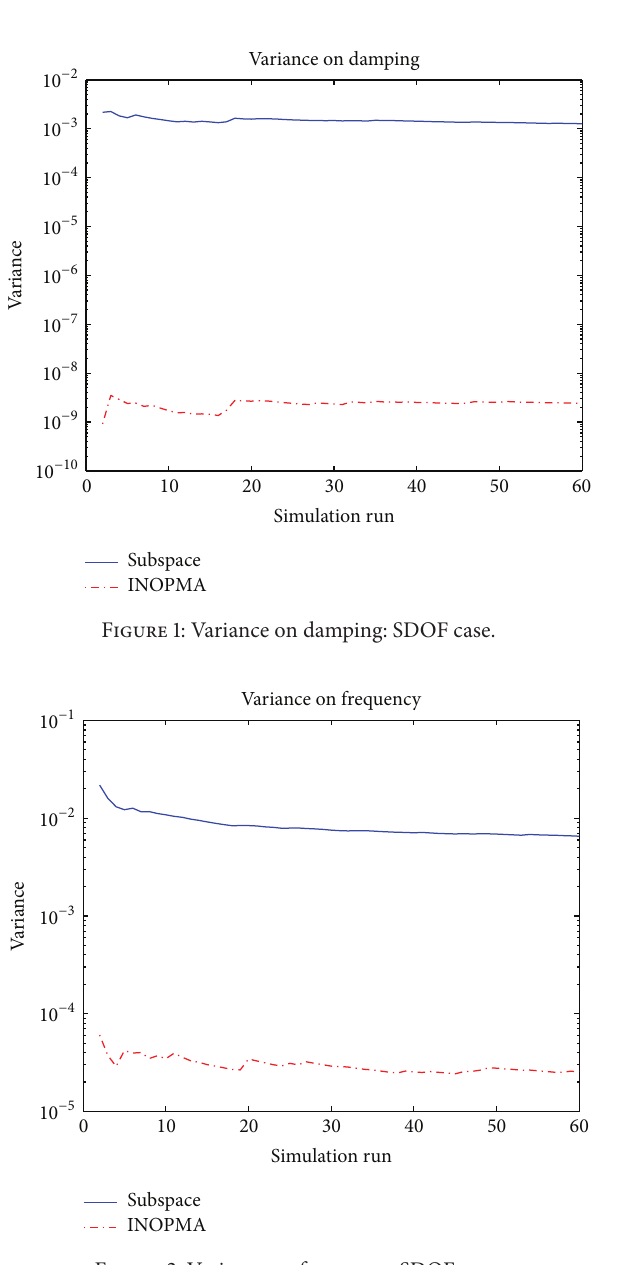
Figure 4: Absolute value of the relative error on